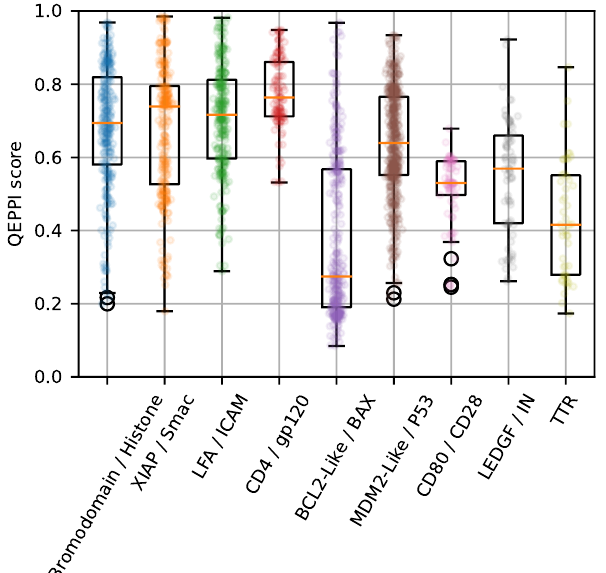
Figure 7. Distribution of QEPPI scores for 9 PPI families with more than 50 compounds targeting each PPI family in iPPI-DB. The jitter overlaid on the boxplots shows the QEPPI scores for all samples in each dataset. Statistics related to this figure are shown in Supplementary Table